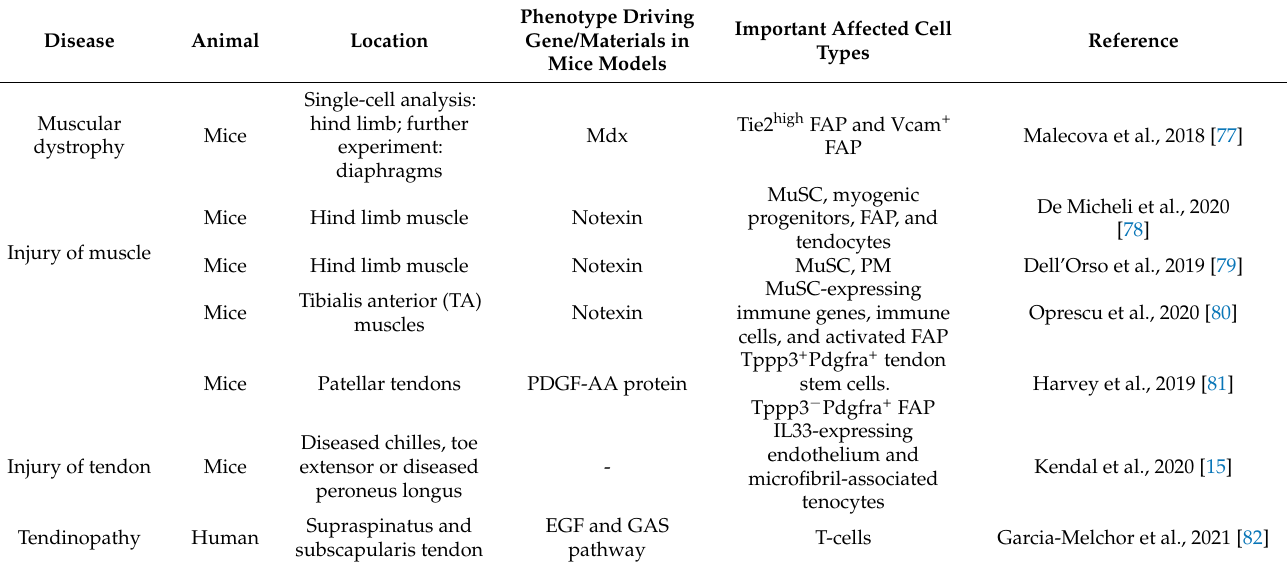
Table 4. Application of single-cell and spatial omics in muscle- or tendon-related diseases.